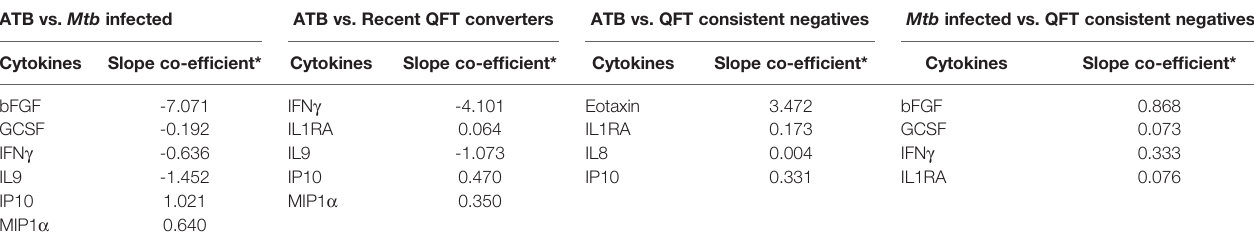
TABLE 2A | Expression and regression coef fi cients for each biomarker of the identi fi ed protein signature. ATB vs. Mtb